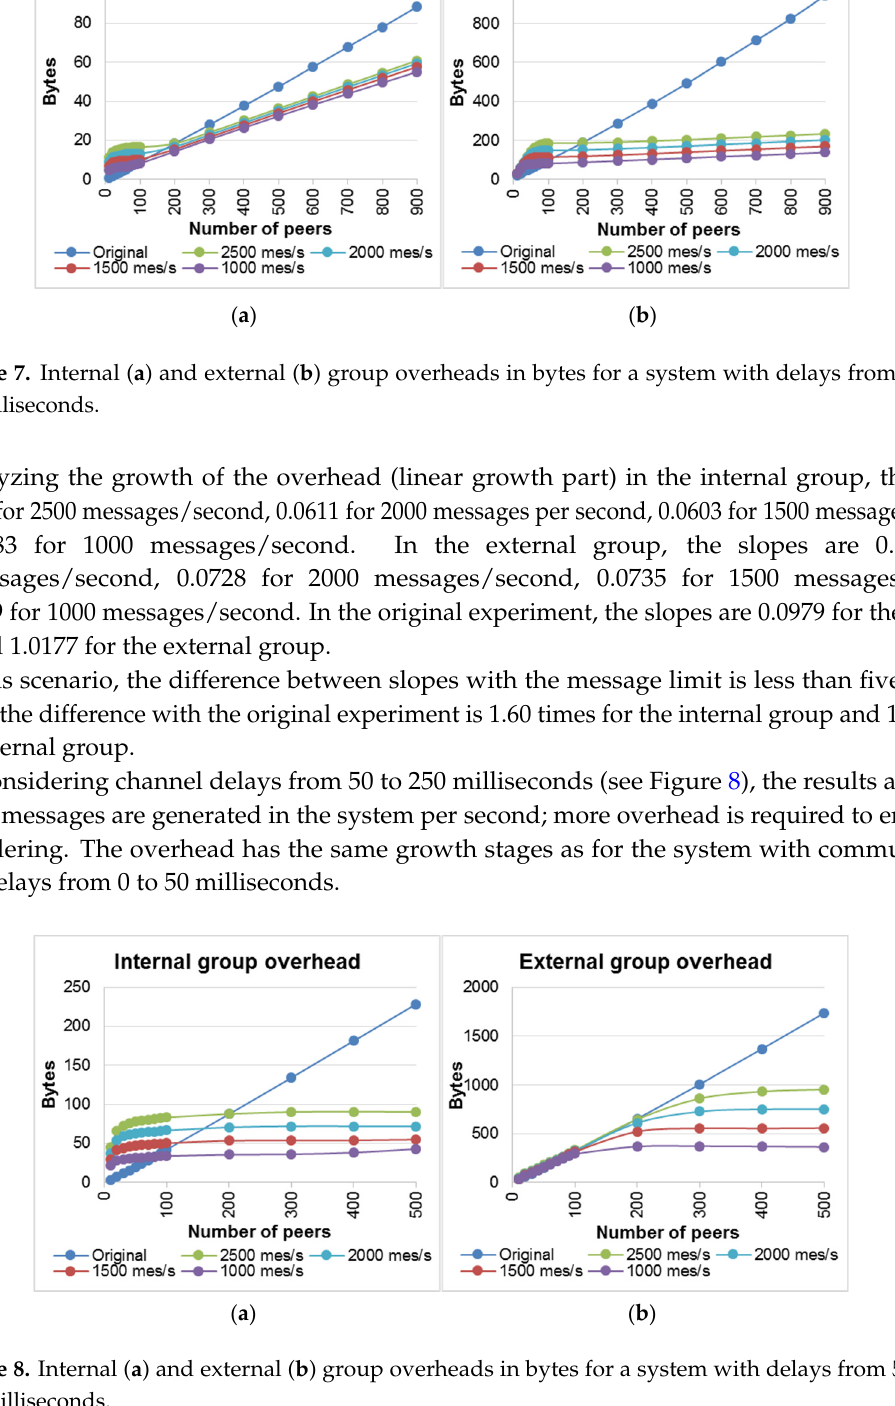
Figure 8. Internal ( a ) and external ( b ) group overheads in bytes for a system with delays from 50 to 250